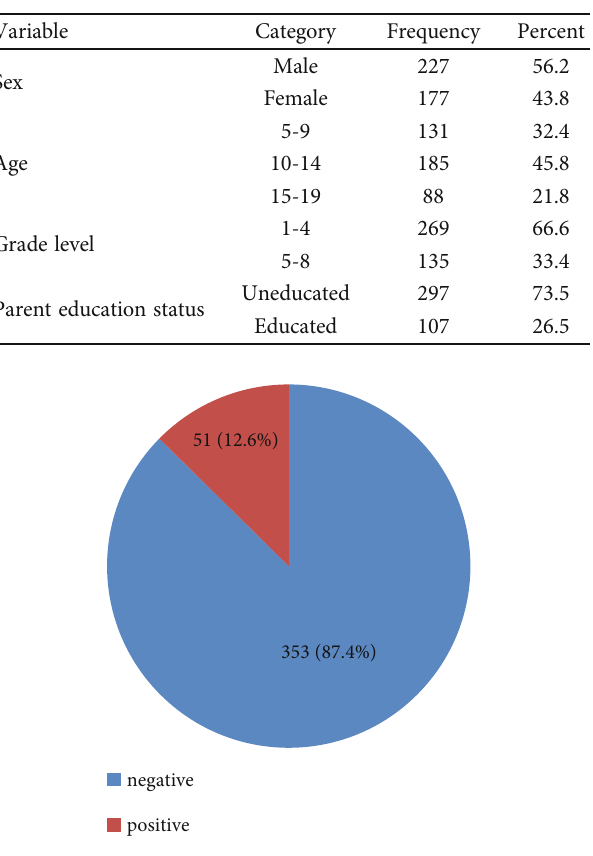
Figure 1: Prevalence of schistosoma mansoni infection among school children in Gichgich and Kibi, Guangua district, northwest Ethiopia